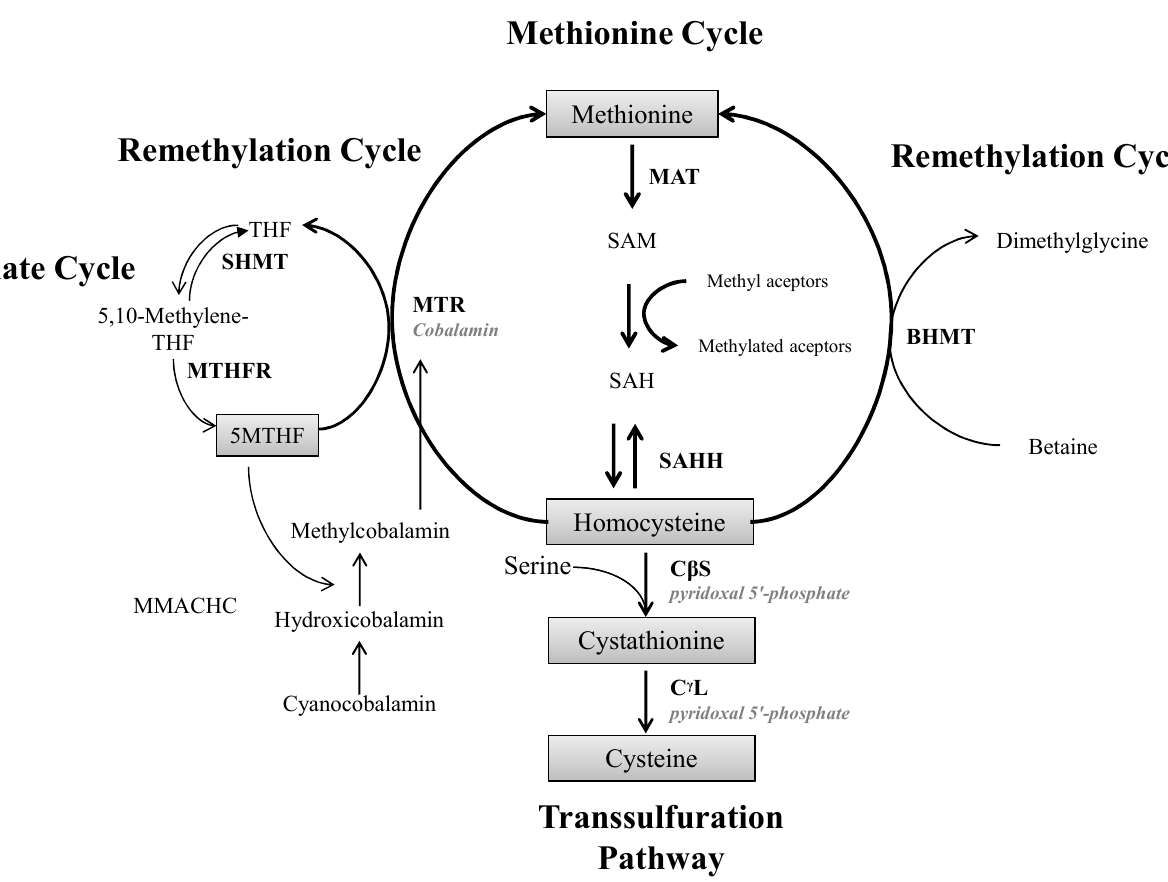
Figure 1. Overview of homocysteine metabolism. MAT: methionine adenosyltransferase; SAM: S-adenosylmethionine; SAH: S-adenosylhomocysteine; SAHH: S-Adenosyl-homocysteine hydrolase; CβS: cystathionine β-synthase; CγL: cystathionine γ-lyase; MTR: methionine synthase; THF: tetrahydrofolate; MTHFR: 5,10-methylene-THF reductase; SHMT: serine-hydroxymethyltransferase; BHMT: betaine- homocysteine methyltransferase; MMACHC: methylmalonic aciduria and homocystinuria type C protein; Enzymes are shown in capitals, and their cofactors in